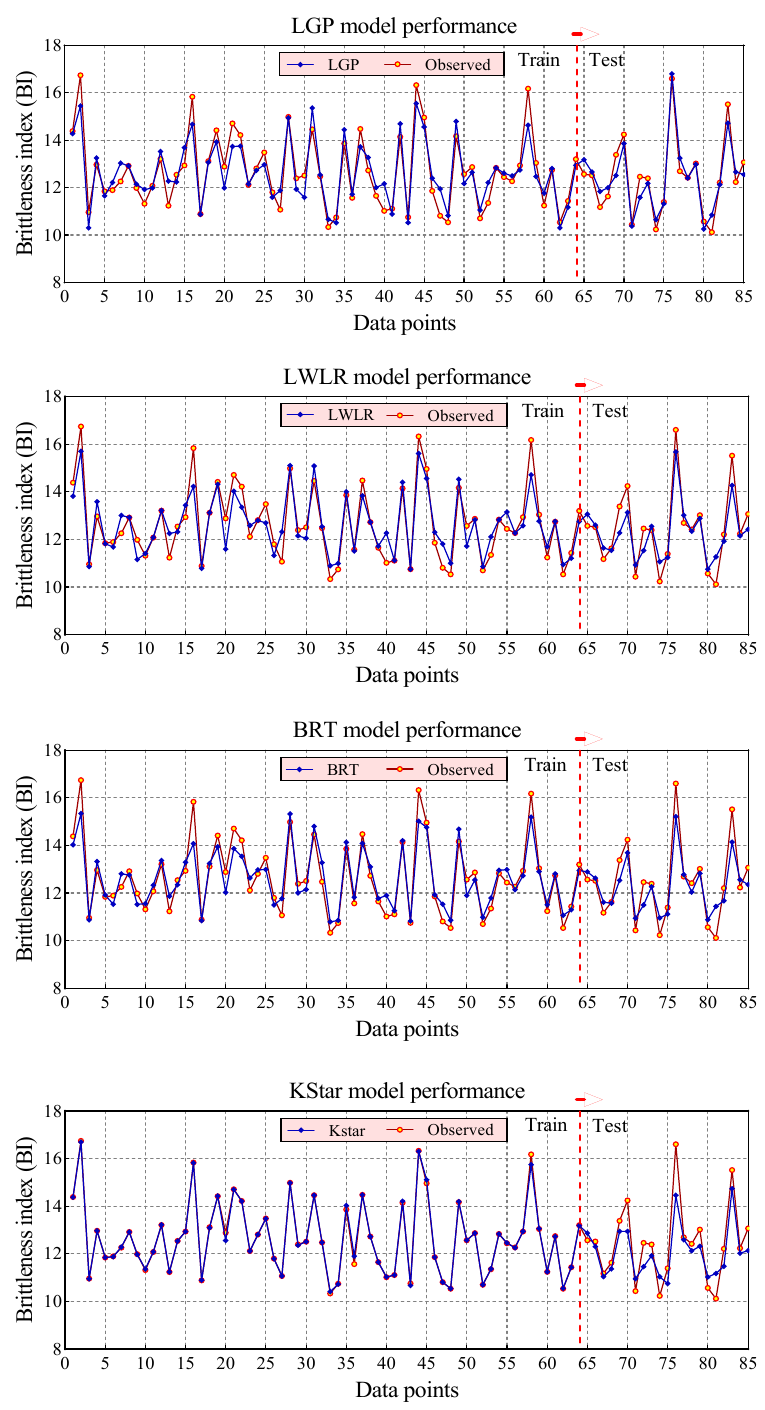
Figure 9. The trend physical plot for comparison between the observed and predicted BI values.